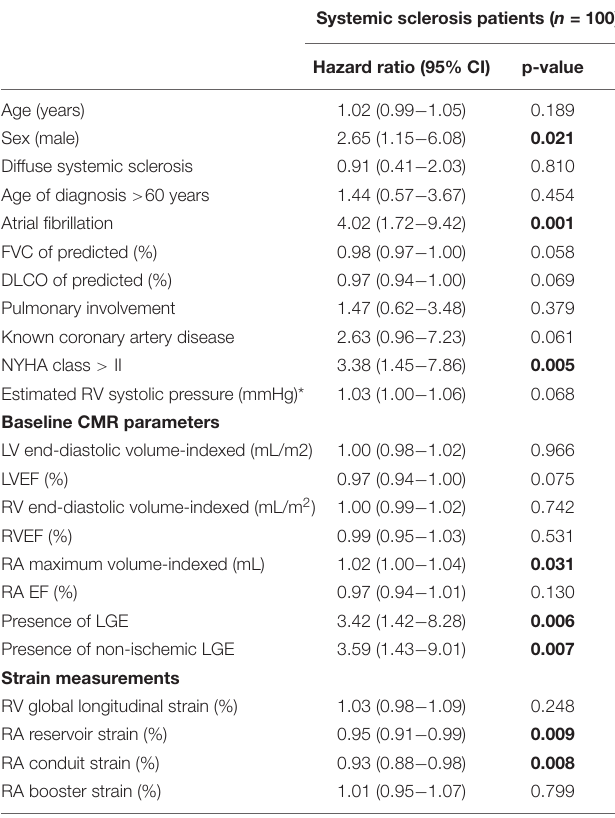
TABLE 4 | Univariable association with all-cause mortality. Systemic sclerosis patients ( n =